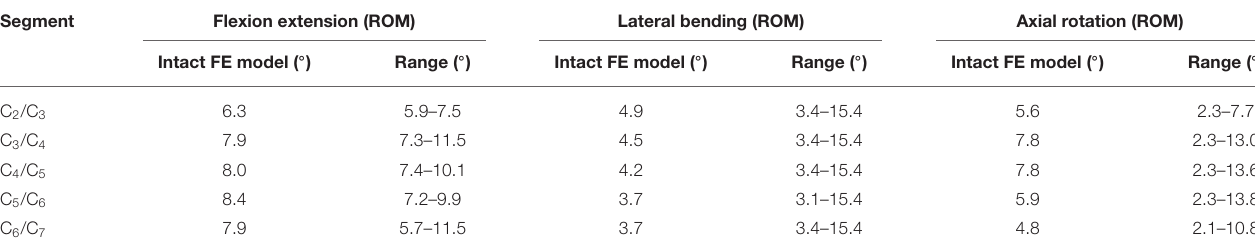
TABLE 2 | ROM validation of intact FE cervical spine model.